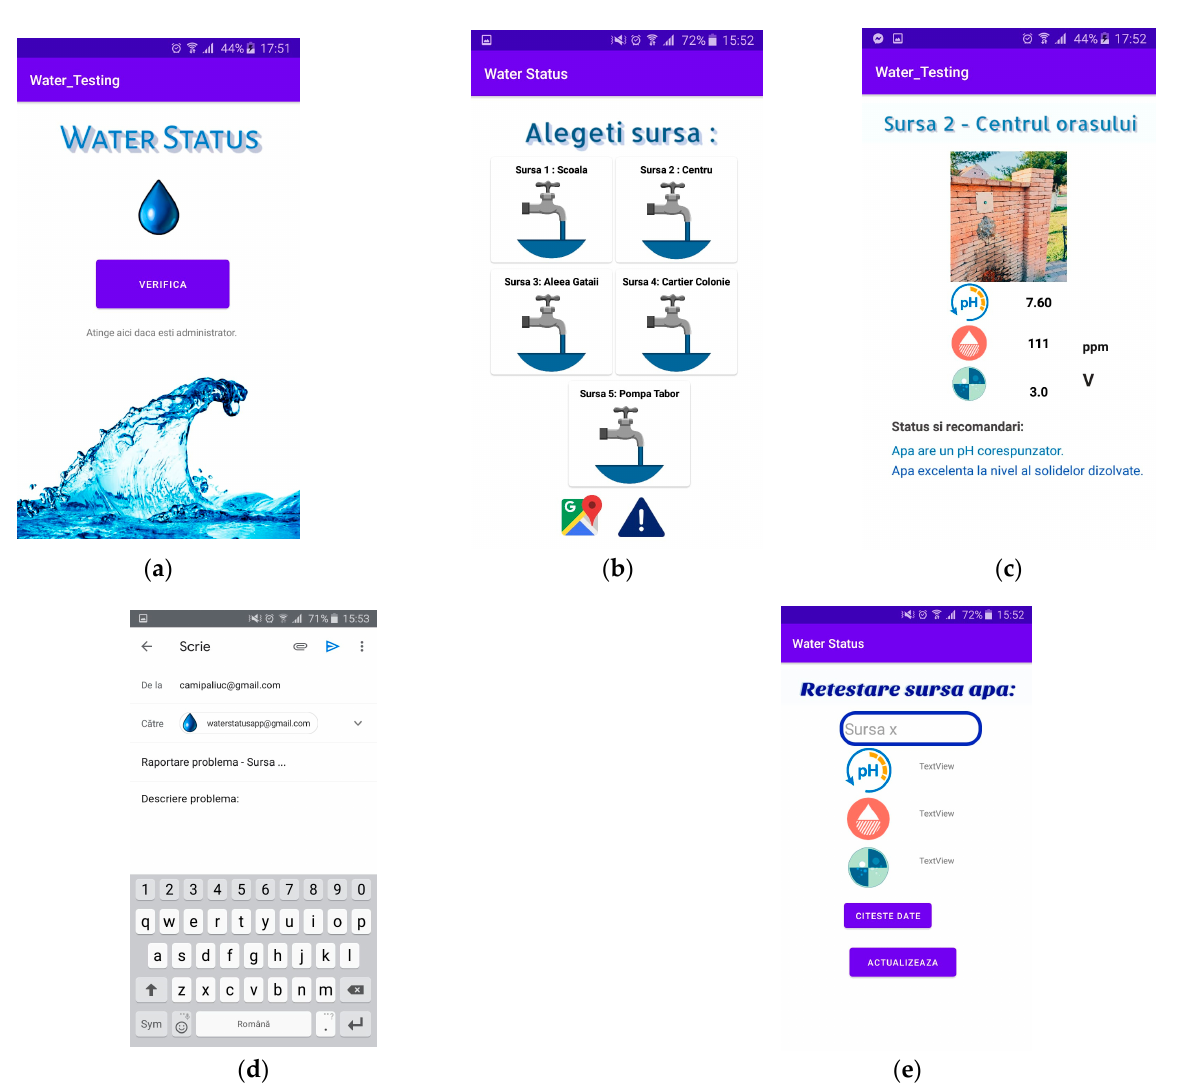
( b ) Figure 6. ( a ) Class diagram of main activity of the mobile application; ( b ) class diagram of the second activity of the water status app. The second activity (Figure 6b) which can be viewed by the user contains CardView- type elements associated with each drinkable water source from Gataia town. The user can select whichever card among the five, in order to view detailed information about that water source (Figure 7). When selecting one of the cards, a new activity is initiated asso- ciated with that water source. For each of the five drinkable water sources of Gataia town, an individual activity was created, with associated classes: source one, source two, source